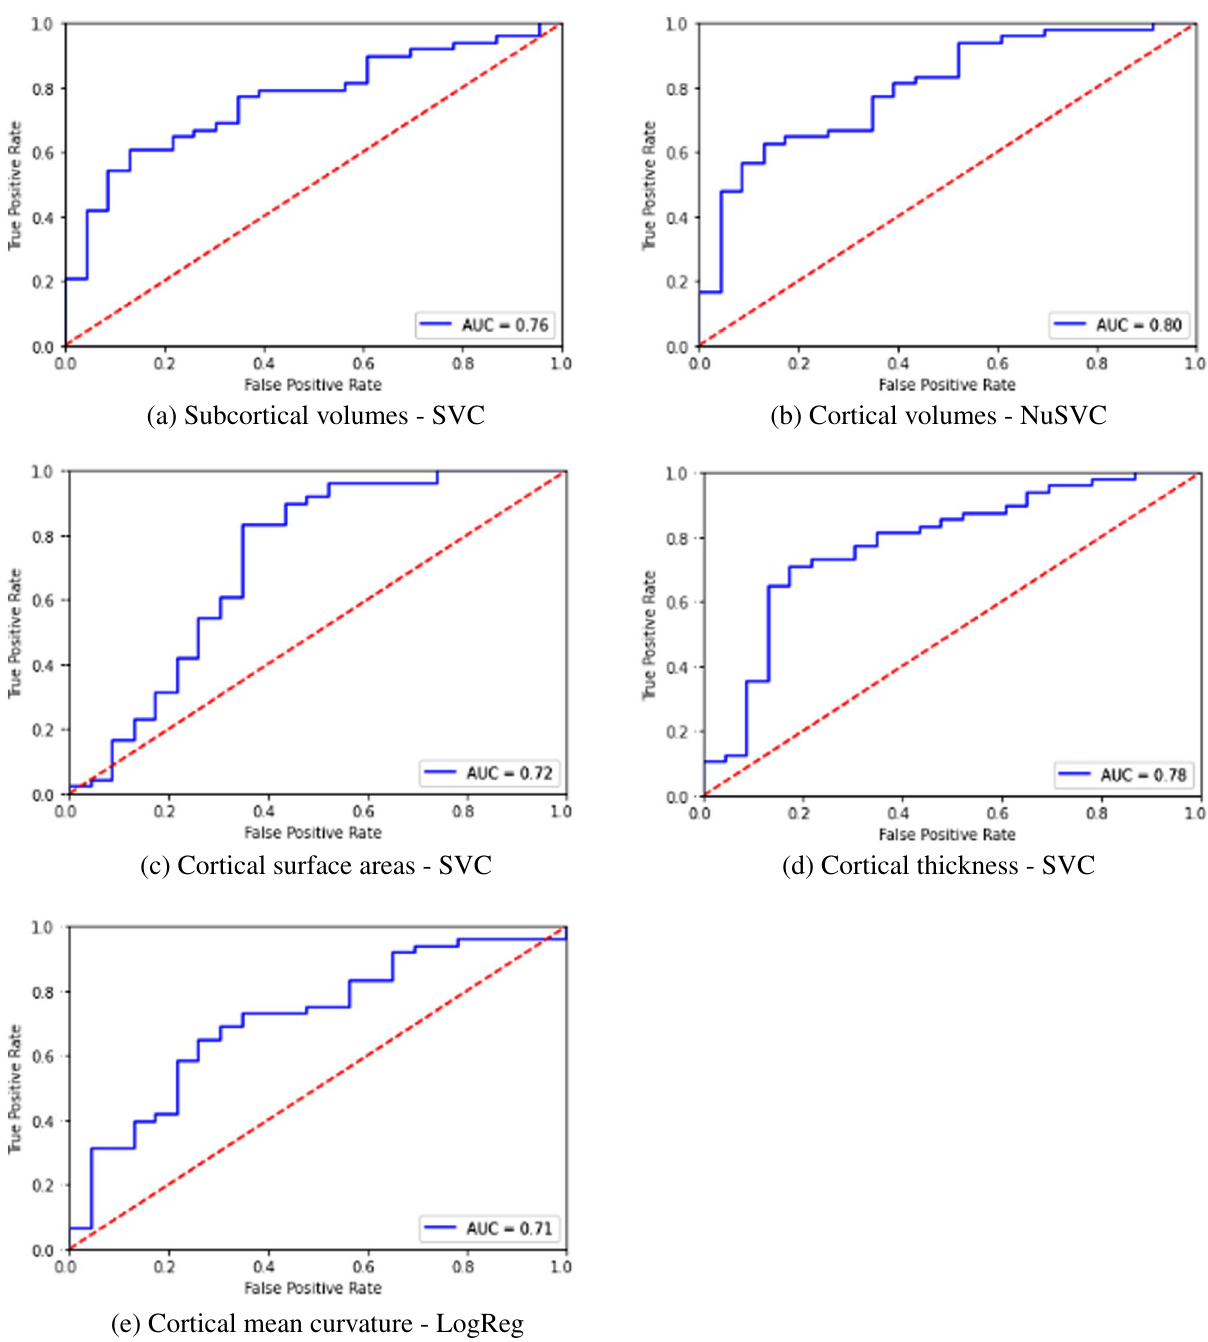
Figure 4. ROC plots for classification using independent feature